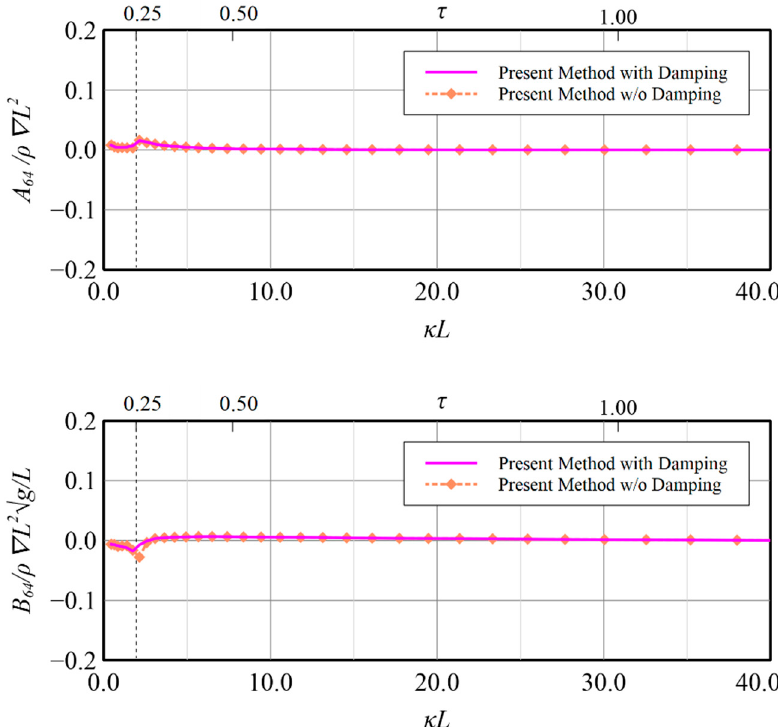
Figure 24. Roll-induced-yaw added mass and damping coefficient at F r = 0.18.